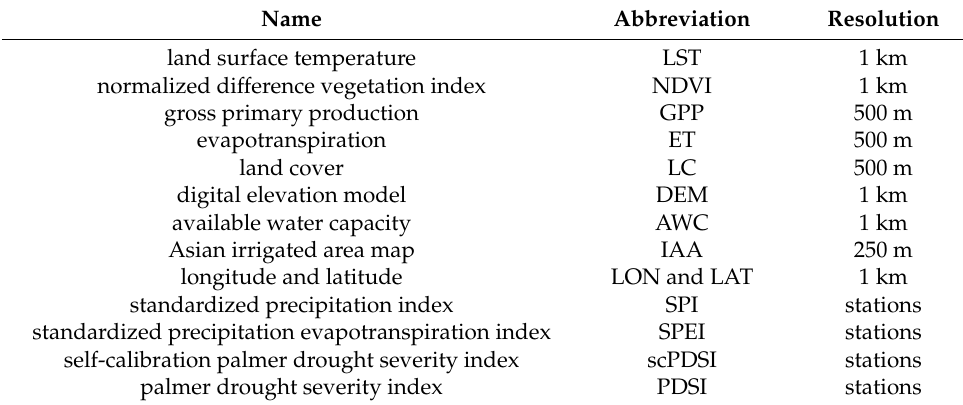
Table 2. Information about the data in this study.